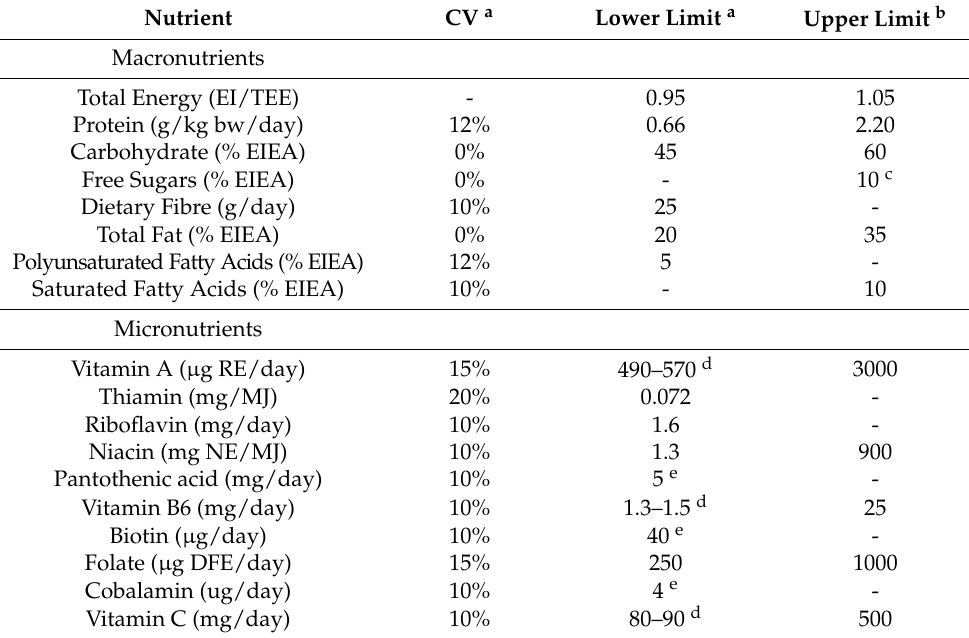
Table A2. Nutrient reference limits used for calculating PANDiet